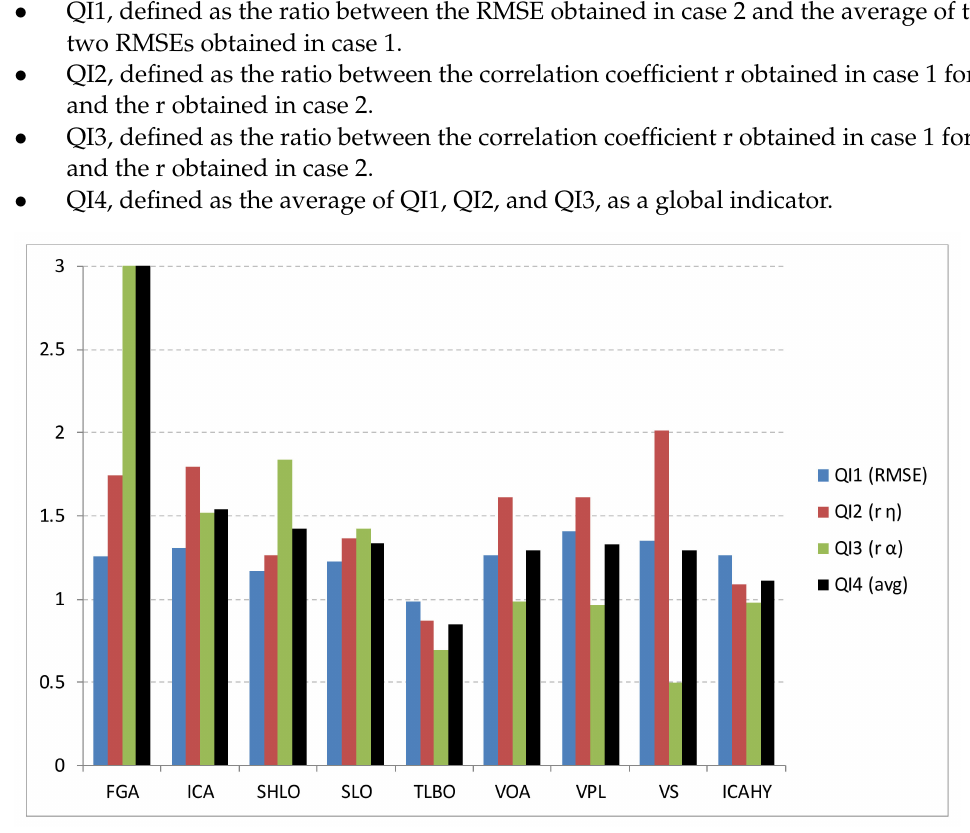
Figure 10. Improvements of two separate networks for each output over a single network with two